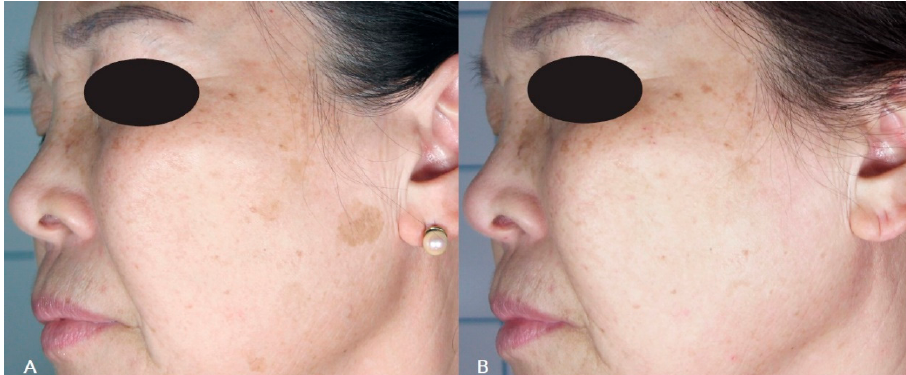
Figure 4. Patient 16 ′ s left side before ( A ) and after treatments ( B ).